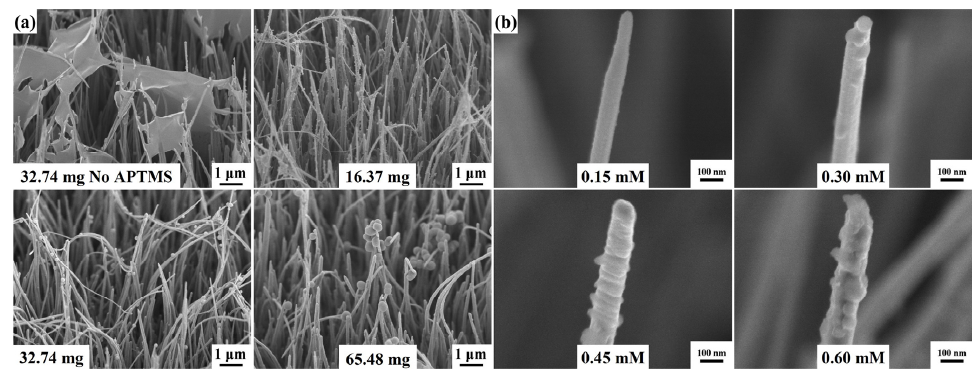
Figure 4. ( a ) The tilt-view FESEM images of CuO@RF nanowires grown at the different weights of resorcinol. The different weights of resorcinol are 32.74 (no APTMS), 16.37, 32.74, and 65.48 mg, respec- tively. ( b ) The tilt-view FESEM images of CuO@RF@Ag nanowires grown at different concentrations of AgNO 3 . The concentrations of AgNO 3 are 0.15, 0.30, 0.45, and 0.60 mM, Figure 5a,b show the FETEM and HAADF images of a CuO@RF@Ag nanowire fab ‐